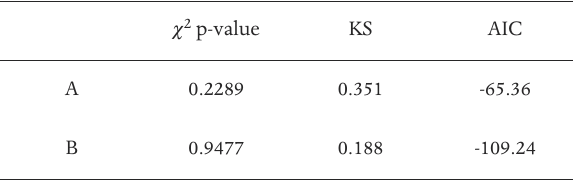
Table 1. Statistics on the two models tested (A and B). The first colums shows the p-value resulting from a | 2 test. In both cases it shows that the normality of residuals can be accepted for a statisti- cal significance of at least 5%. The second column shows the ratio between the critical values at a significance level of 5% and the re- trieved Kolmogorov-Smirnov statistics. Since both values are lower than 1 the goodness-of-fit is achieved by both models. The third col- umn shows the AIC value for the two models.